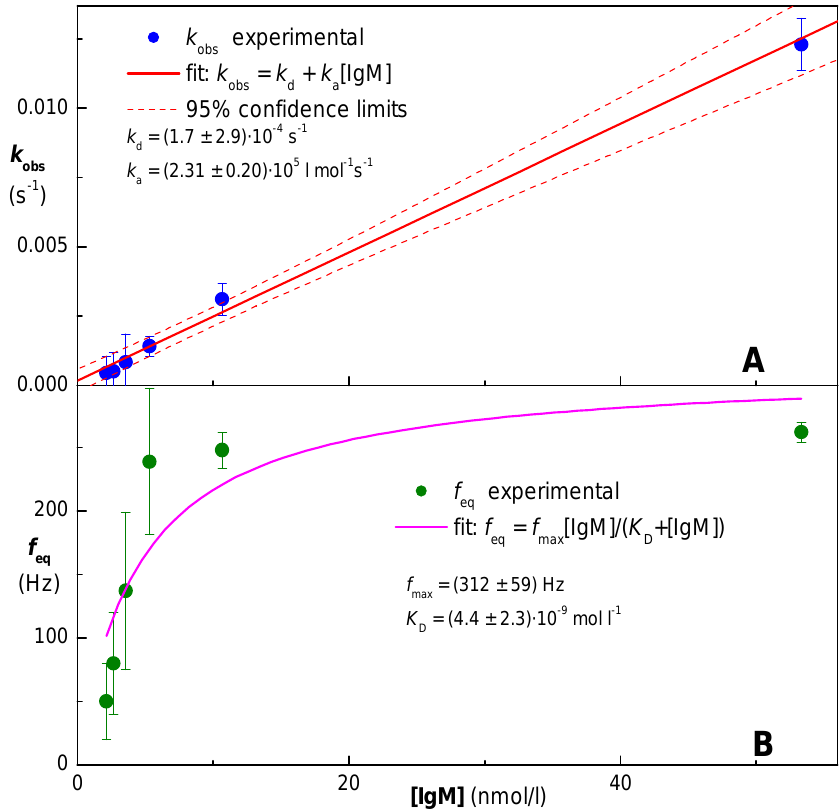
Fig. 6. Evaluation of the kinetic parameters for the mAB 4H3B9D3. The binding traces (similar as shown in Fig. 5) were approximated by the eq. 2 and the parameters k (top, blue) and f (bottom, obs eq olive) obtained using the non-linear regression are plotted vs. the corresponding molar concentration of the antibody. The dependence of k was linearized (top, red line), the dependence of f was fitted to a obs eq hyperbolic equation (bottom, magenta